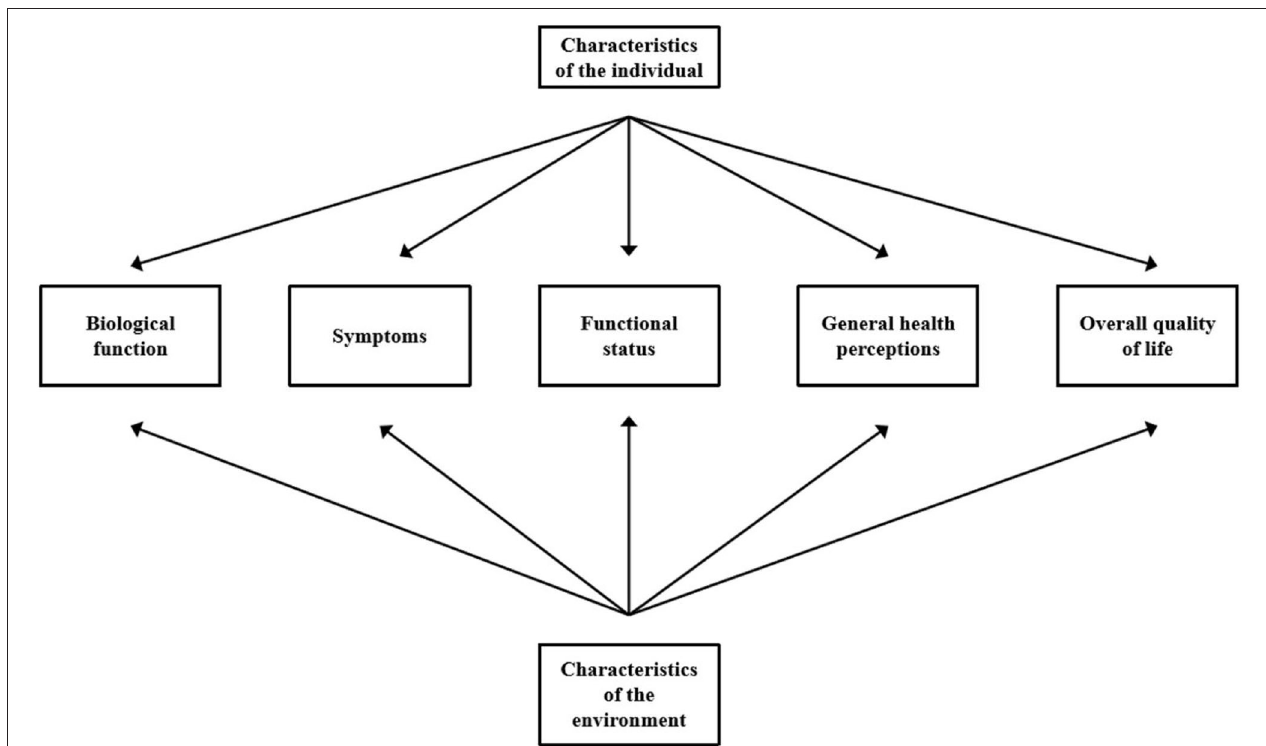
FIGURE 1 | Revised Wilson and Cleary model of health-related quality of life. Adapted from “Linking Clinical Variables with Health-Related Quality of Life: A Conceptual Model of Patient Outcomes,” by Wilson and Cleary ( 26). Copyright by JAMA . Used with